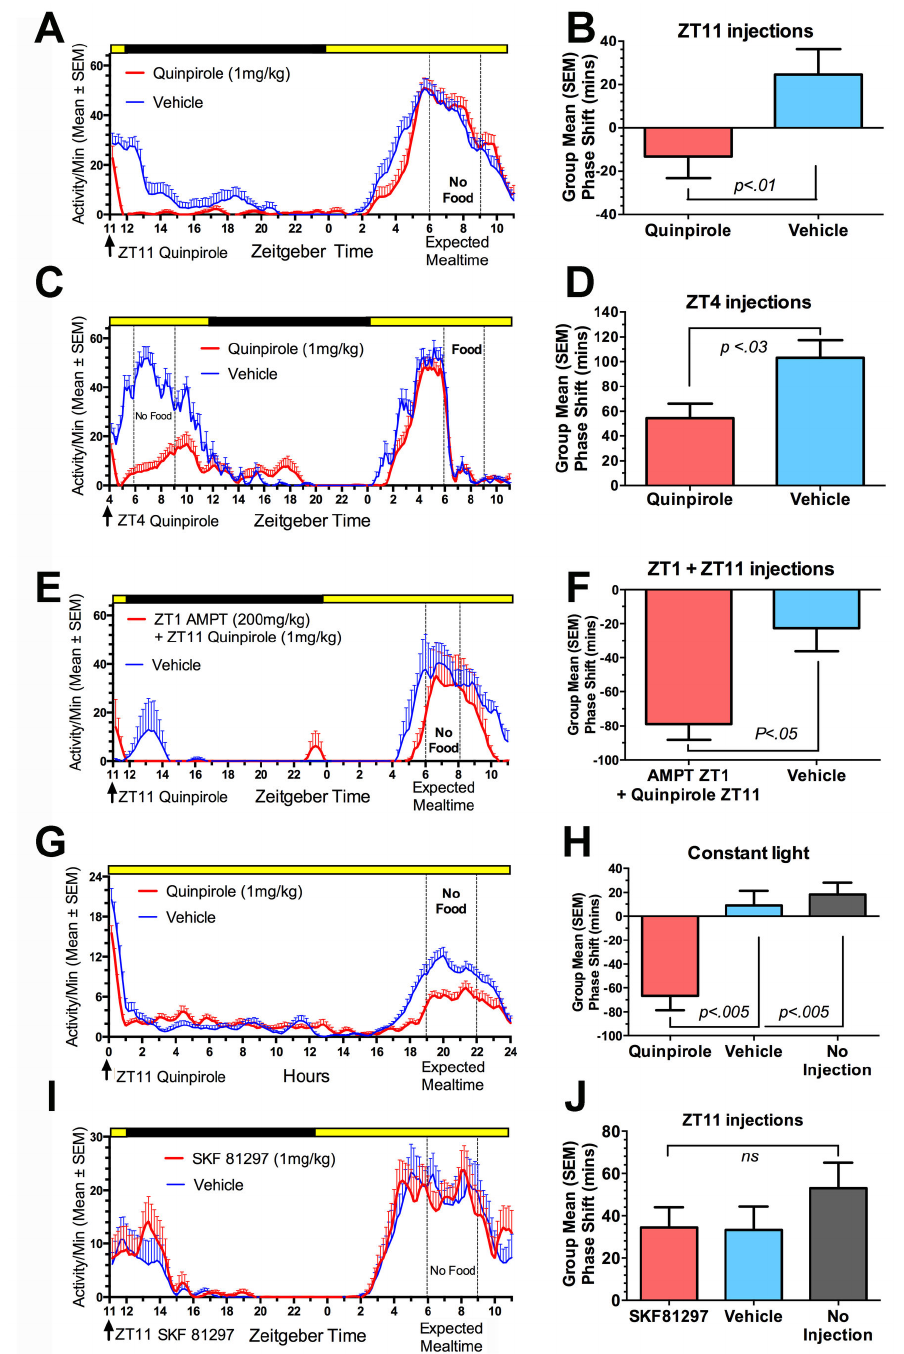
Figure 2. Group mean (+ SEM) average waveforms of activity during restricted feeding on the day following injections of drug (red curves) or vehicle (blue curves) in Experiments 1-4. Injection times (in zeitgeber time, where ZT0 is lights-on by convention) are indicated by the arrows and scheduled mealtimes by the vertical dotted lines. The LD cycle is indicated by the black and yellow bars (A,C,E,I); note, however, that in those experiments, the lights were kept off during the days represented here (i.e., the day after injection). The bar graphs represent phase shifts of premeal activity onset on the day after the injections by comparison with the 4 days prior to injection. A delay in the onset of premeal activity is represented by negative values, and an advance by positive values. Note that quinpirole injections induced delays relative to vehicle injections in all experiments. P-values are the results of paired t-tests. doi: 10.1371/journal.pone.0082381.g002 PLOS ONE |